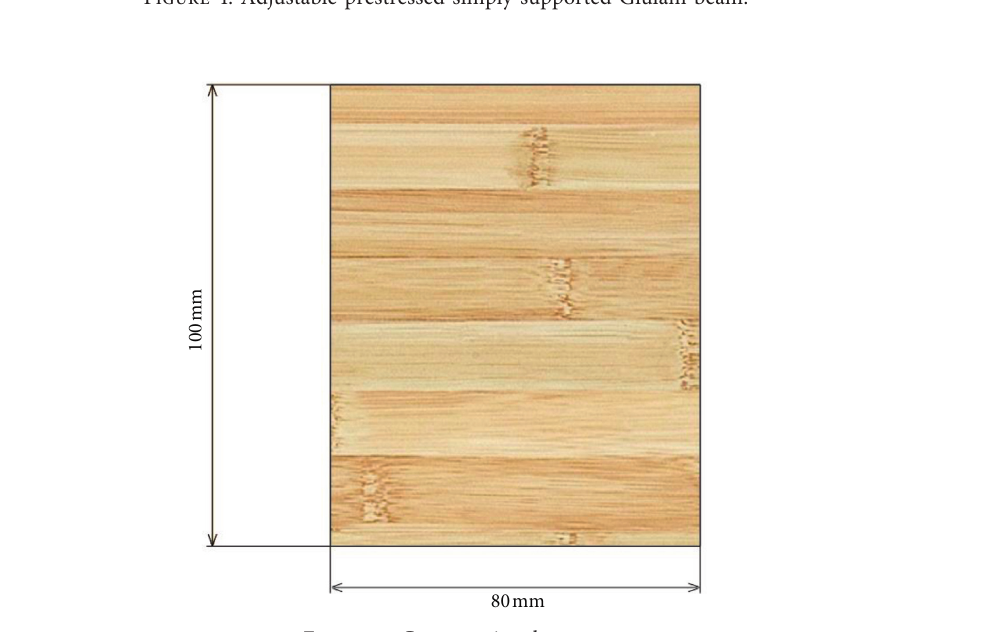
Figure 4: Adjustable prestressed simply supported Glulam beam.